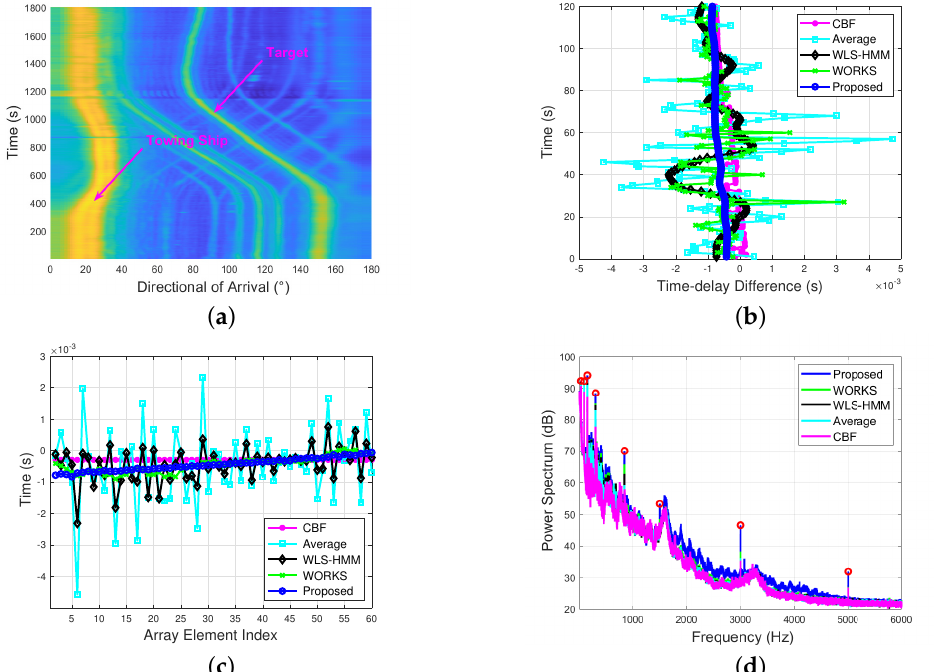
Figure 8. Performance comparisons. ( a ) Direction time record during a turn of the towing ship. ( b ) The estimates of the time-delay difference between the first two hydrophones for all the ob- servations. ( c ) The estimates for inter-hydrophone time-delay difference of the towed array at the 67th observation. ( d ) The average for the power spectrum of the enhanced signal in 120 frames of